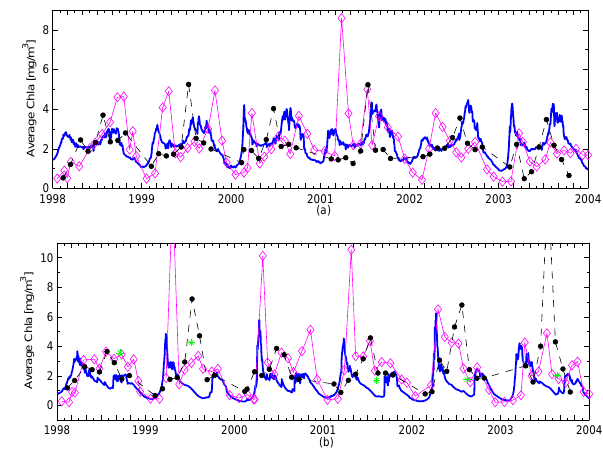
Fig. 11. Modelled (thick solid line) and in-situ data (denoted with blank magenta diamonds and green asterisks) of average Chl a [mg/m 3 ] at: (a) – BS, (b) – GS. Data from satellite images (EMIS database) is presented with filled black circles connected with a dash